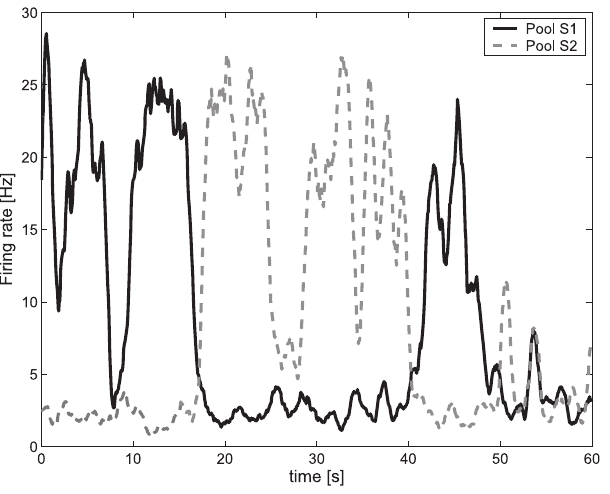
Figure 5. Stability and Distractibility as a Function of the Distractor Strength and the Synaptic Efficacies We assessed how often in 100 trials the average activity during the last second (2–3 s) stayed above 10 Hz in the S1 attractor. The modulation of the synapses NMDA: (cid:2) 1 and GABA: (cid:2) 1 corresponds to a reduction of 4.5% and 9%, respectively. The strength of the distractor stimulus applied to S2 is an increase in firing rate above the 2.4-kHz background activity, which is distributed among 800 synapses per neuron. The lower the sustained activity in S1, the higher is the distractibility. The standard deviations were approximated with the binomial